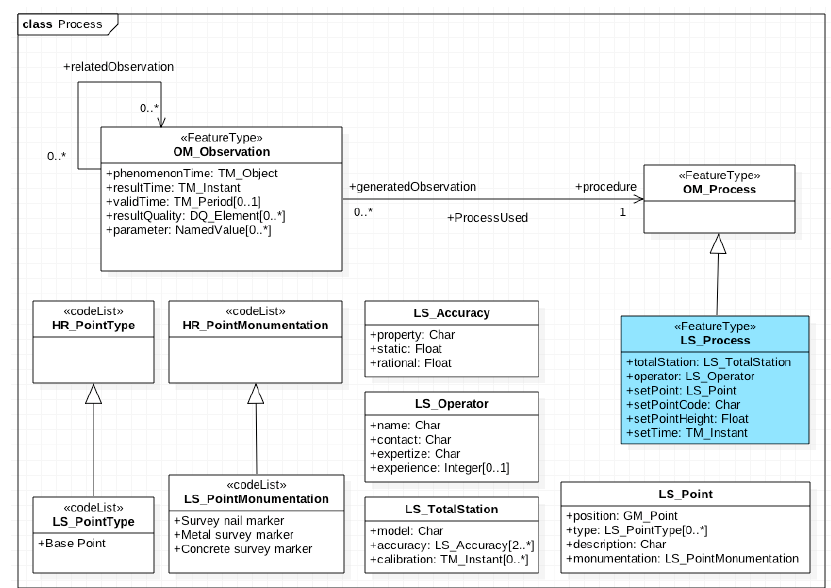
Figure 4. ‘LS_Process’ core class diagram.